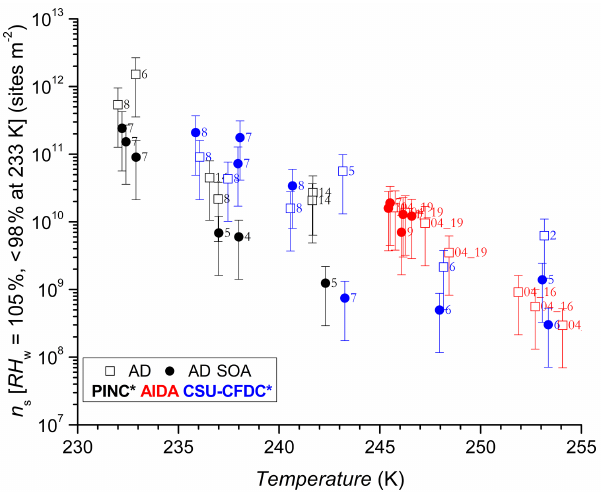
Figure 7. INAS densities as a function of temperature for AD and AD SOA. Error bars are based on 75% uncertainty in particle siz- ing due to spherical assumption and surface area determination and 15% uncertainty from particle counting resulting in a relative error of 76% in INAS density . Numbers next to data points refer to ex- periment number records for coating thicknesses shown in Table 1. The asterisk ( ∗ ) denotes that the PINC and CSU-CFDC data have been adjusted by a factor of 3 (see text Sect. 4 for details).